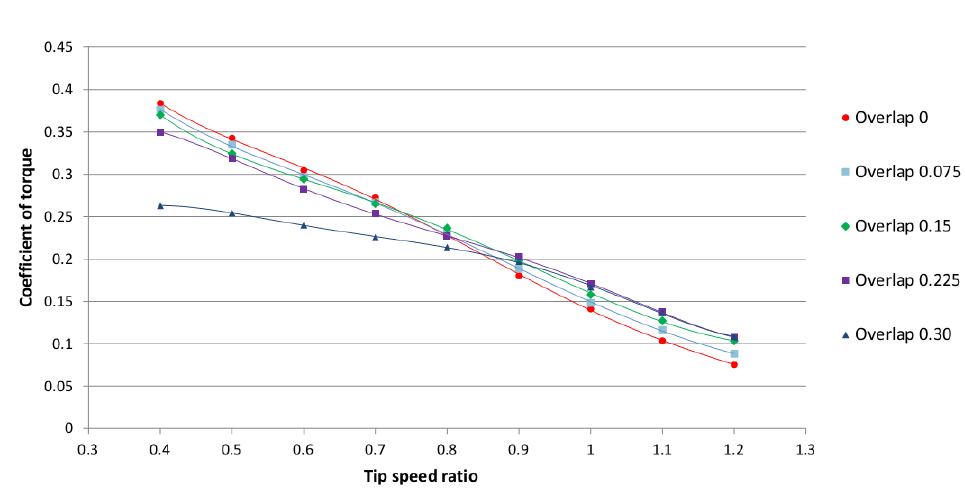
Figure 6: Coefficient of torque for the Classical Savonius with different overlap ratios in